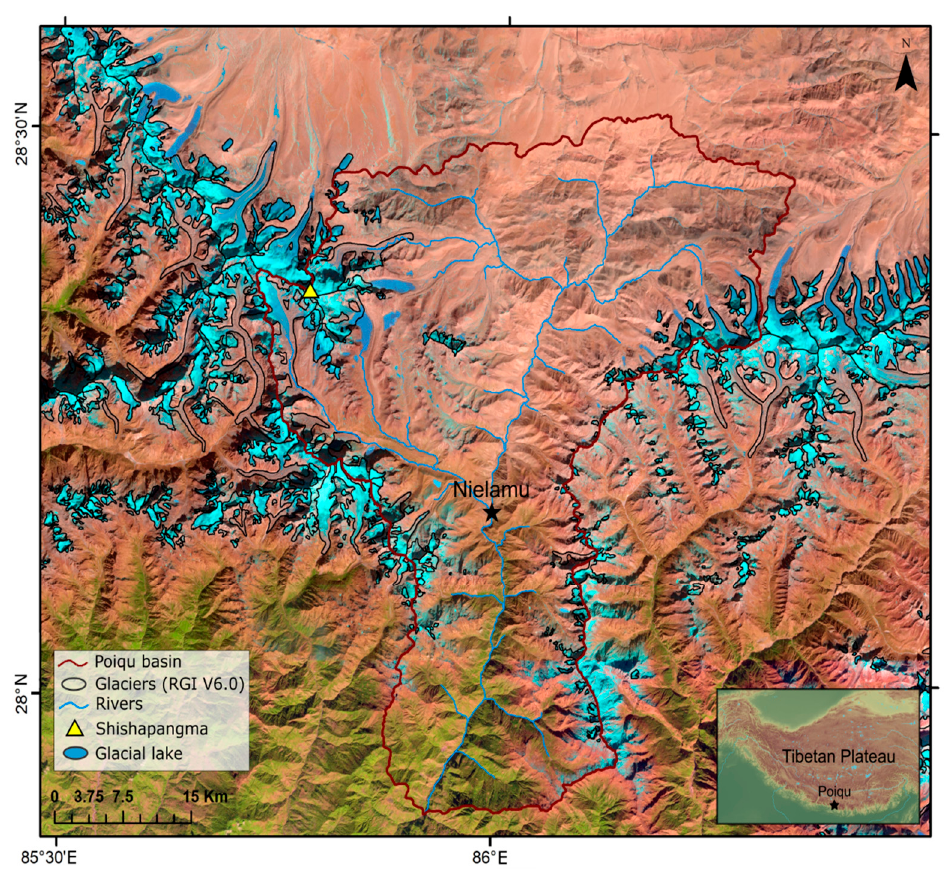
Figure 1. Study region, its glaciers and glacial lakes; background image: Sentinel-2 MSI image mosaic from Dec 2021, false colour composite (SWIR-NIR-RED).